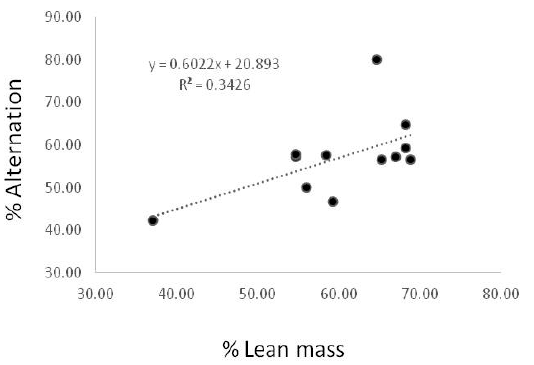
Figure 4. Correlation between % lean mass and spontaneous alternation behavior. Correlation between % lean and spontaneous alternation on Y maze in CON and DM group. A significant inverse relationship was observed between % lean and spontaneous alternation on Y maze in the CON and DM groups R = 0.3426, p < 0.05, n = 18).